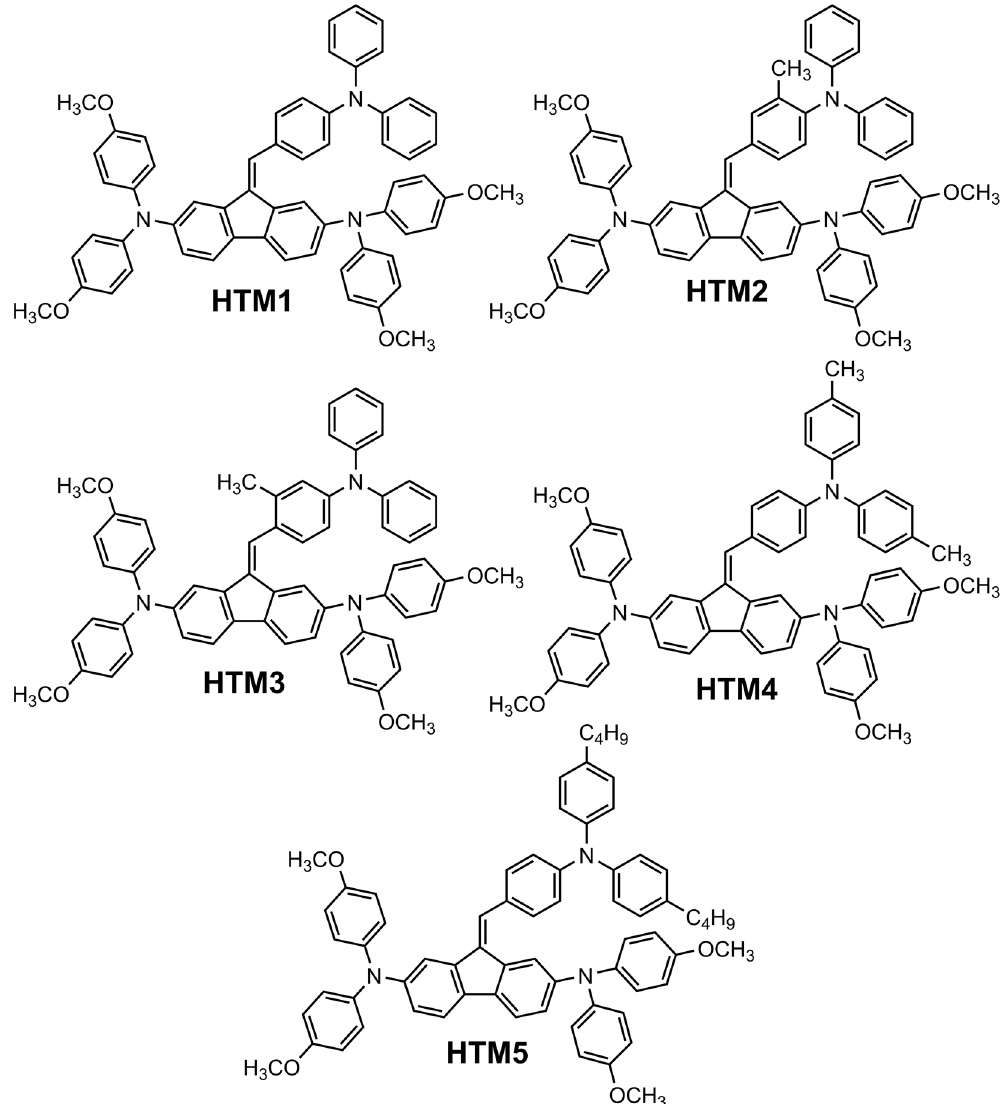
Figure 1. Structures of the investigated hole transporting materials HTM1–5